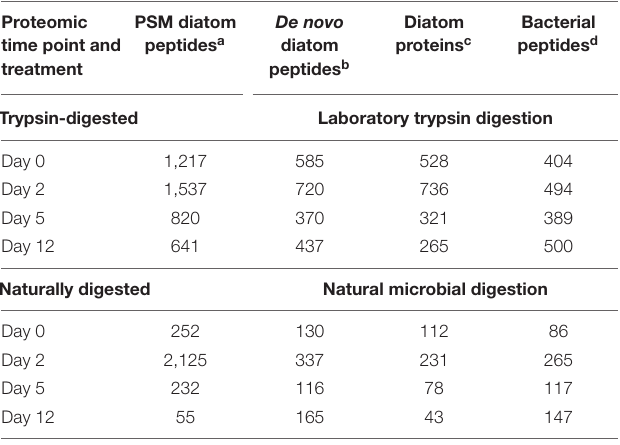
TABLE 1 | Diatom and bacterial peptide and protein